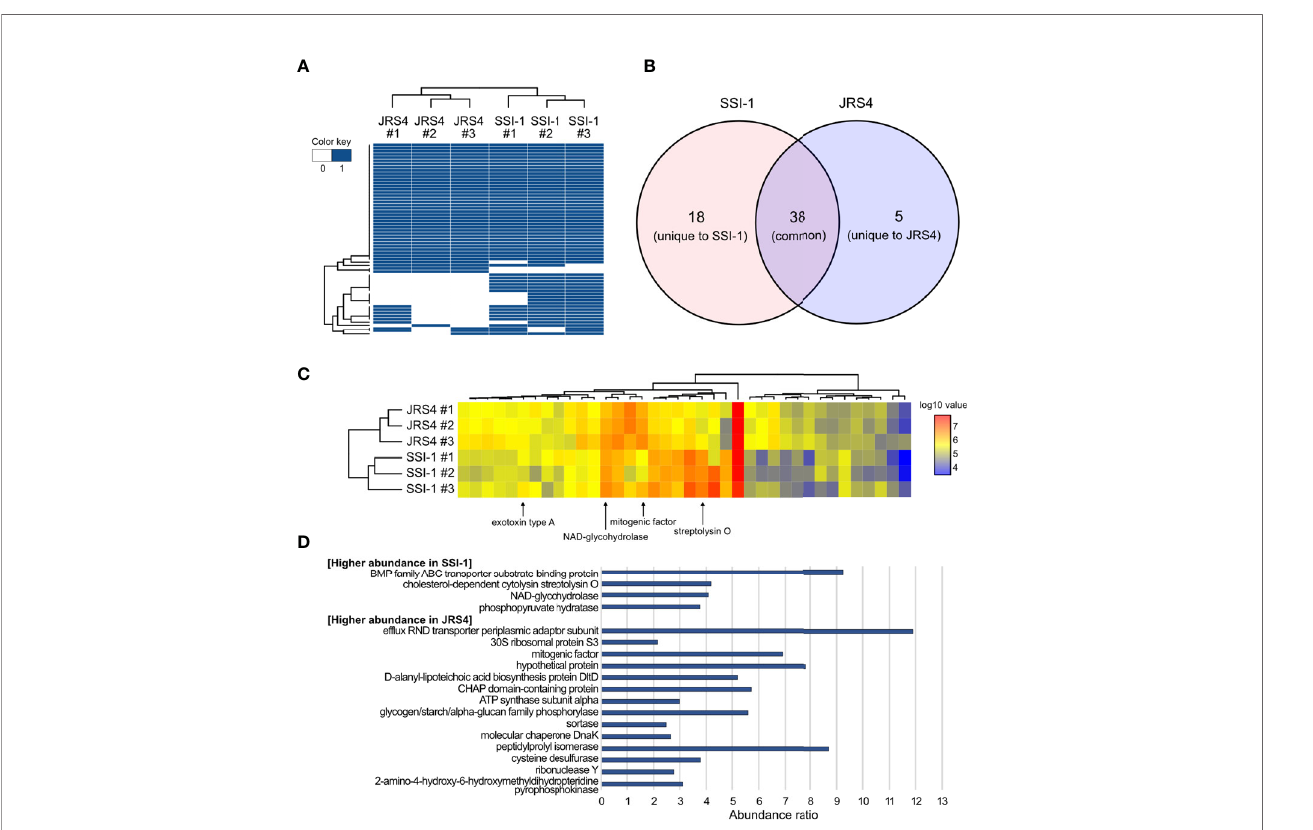
FIGURE 2 | Comparison of proteome pro fi les of EVs from S. pyogenes str. SSI-1 and JRS4. (A) Heatmap representation of clustering according to presence and absence of proteins in EV from SSI-1 and JRS4, with biological triplicates. (B) Venn diagram of EVs-derived proteins identi fi ed in SSI-1 and JRS4. (C) Heatmap representation of clustering according to log10-transformed abundance values of common proteins identi fi ed in two strains. Arrows indicate well-known virulence factors in GAS. (D) Abundance ratio signi fi cantly higher (> 2.0) in SSI-1 or JRS4 that are shown in bar-chart. Heatmap generation was implemented in R by using heatmap.2 from ggplots